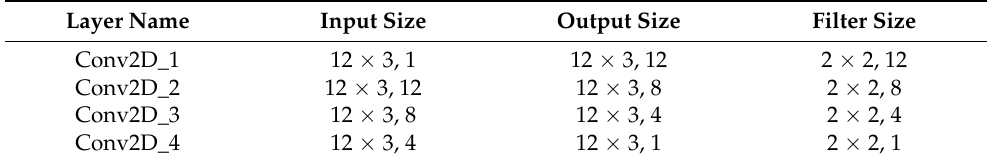
Table 2. Detailed structure of DLDC with four convolutional